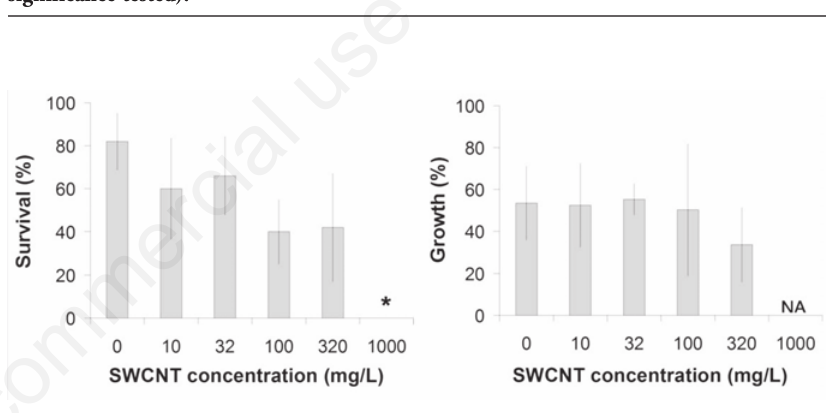
Figure 2. Accumulation of single-walled carbon nanotubes (SWCNT) in Hyalella azteca. Organisms exposed to medium M4 (A) or SWCNT at 320 mg/L (B) and mean proportion (%) of amphipods with SWCNT in their gut after exposure to different concentrations of SWCNT in M4 for 14 days (C). N indicates the number of organisms used for the calcu- lation: N1 and N2 correspond to the 14 days test (1) and (2) respectively (no statistical significance tested).